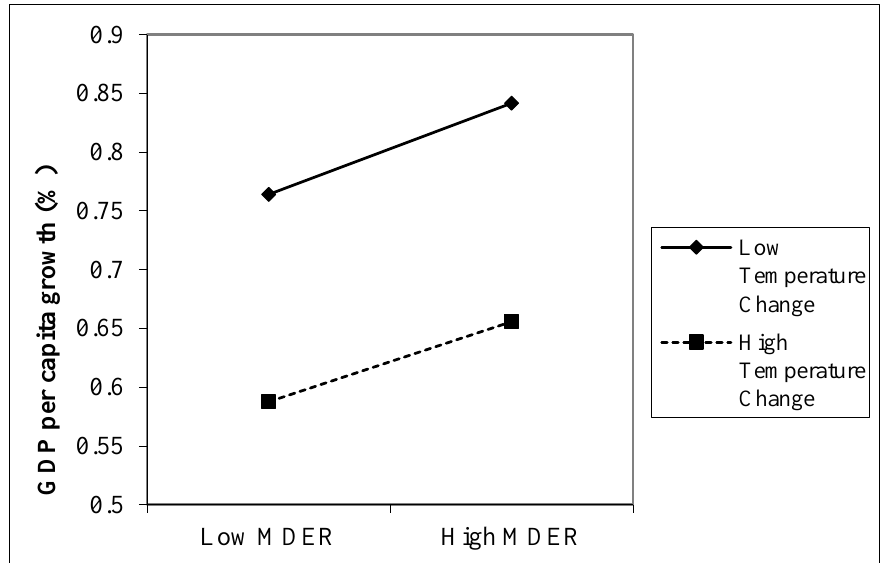
Figure 2. The two-way interaction effects for MDER and moderator (temperature change).